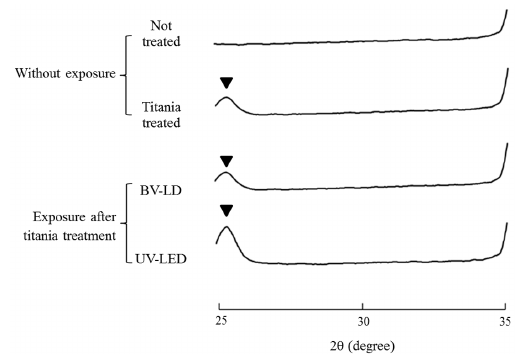
Figure 2. Changes in the XRD patterns of each specimen. doi: